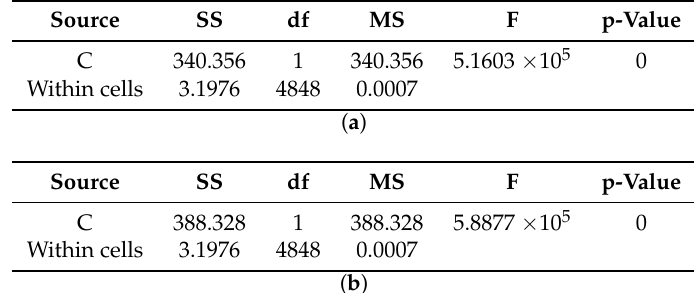
Figure A11. ANOVA tables for the analysis of the effect of factor C (amount of biased observations) on the expected accuracy. ( a ) One-way ANOVA for factor C given B = 1. ( b ) One-way ANOVA for factor C given B = 2.